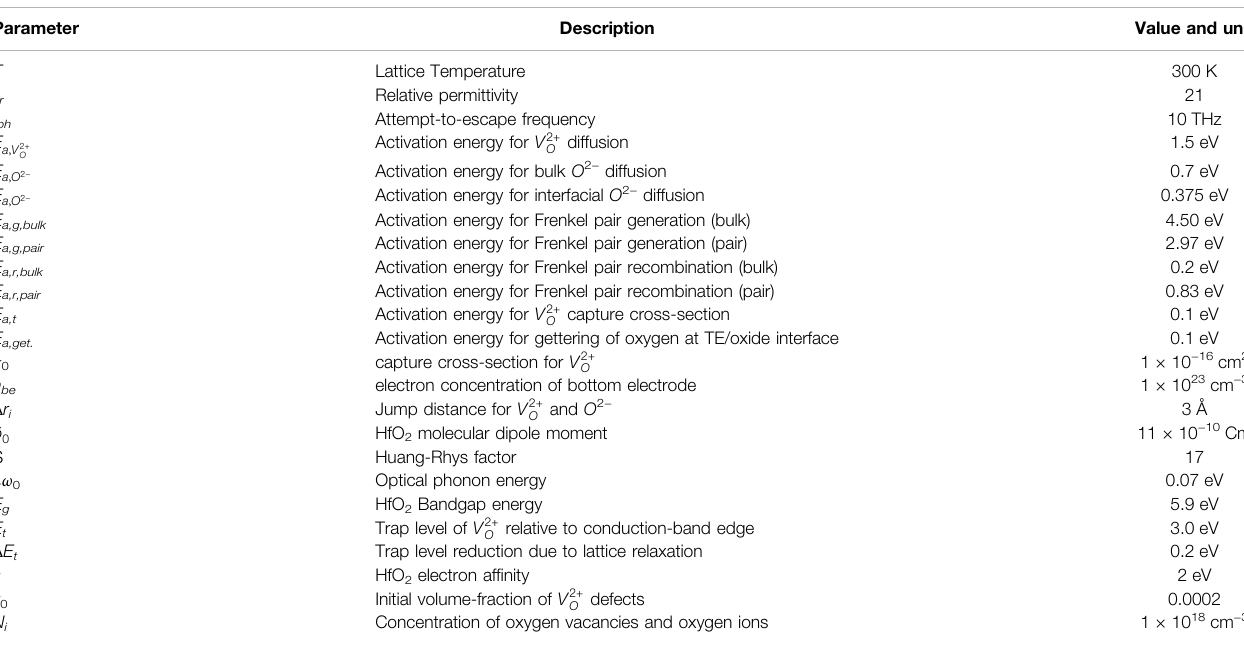
TABLE 1 | Summary of nominal materials parameters used in this work unless otherwise stated.